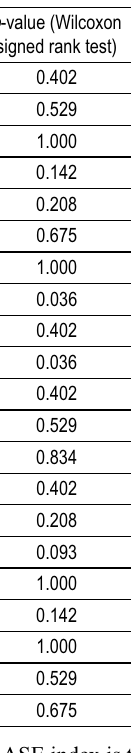
Table 4. ASE return behavior over a period of